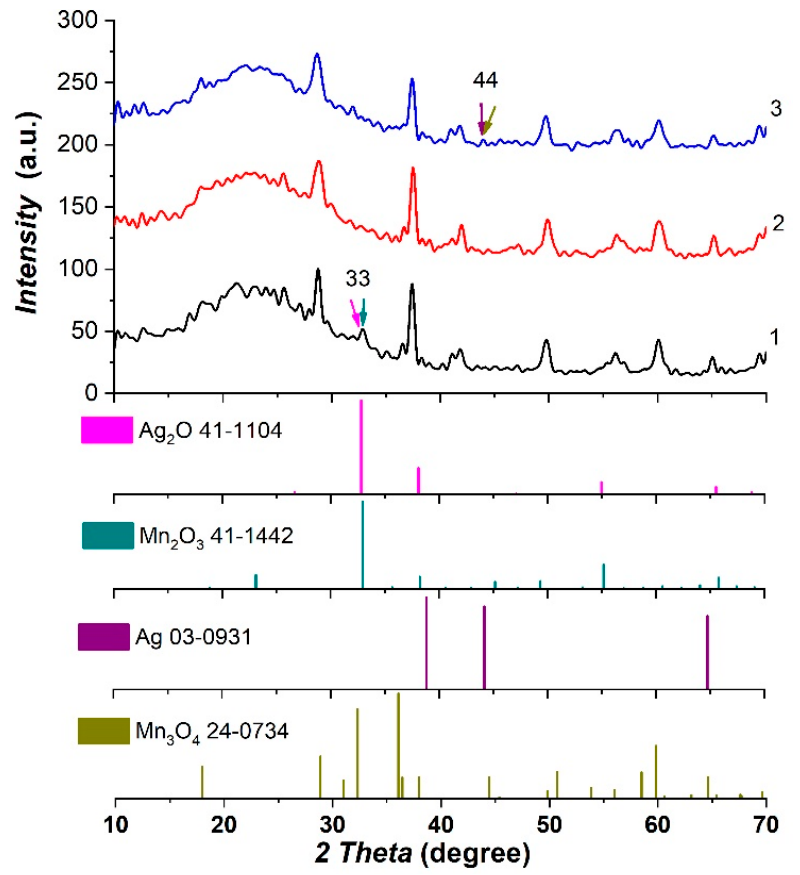
Figure 1. XRD patterns for prepared catalysts: 1—Ag/OMS-2, 2—Ag/0.05Fe–OMS-2, 3—Ag/0.1Fe–OMS-2.